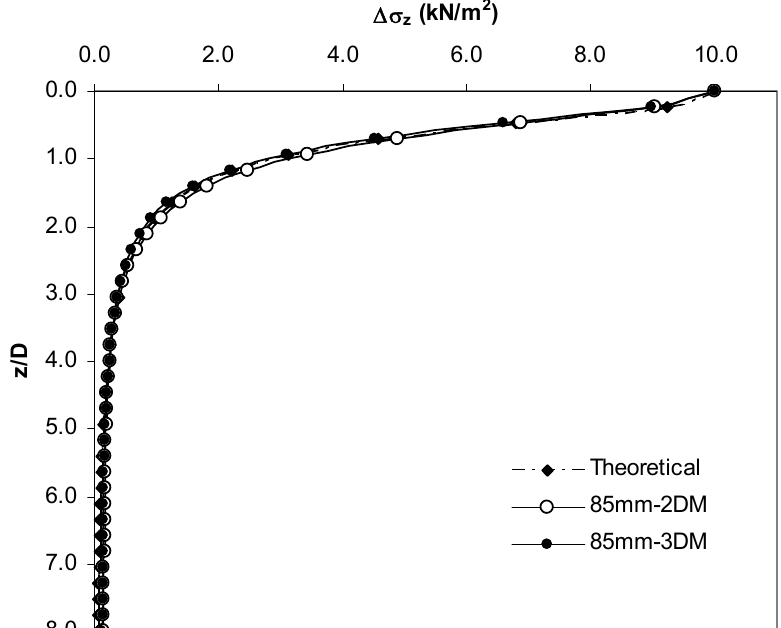
Figure 19. Vertical stress distribution (D = 85 mm).